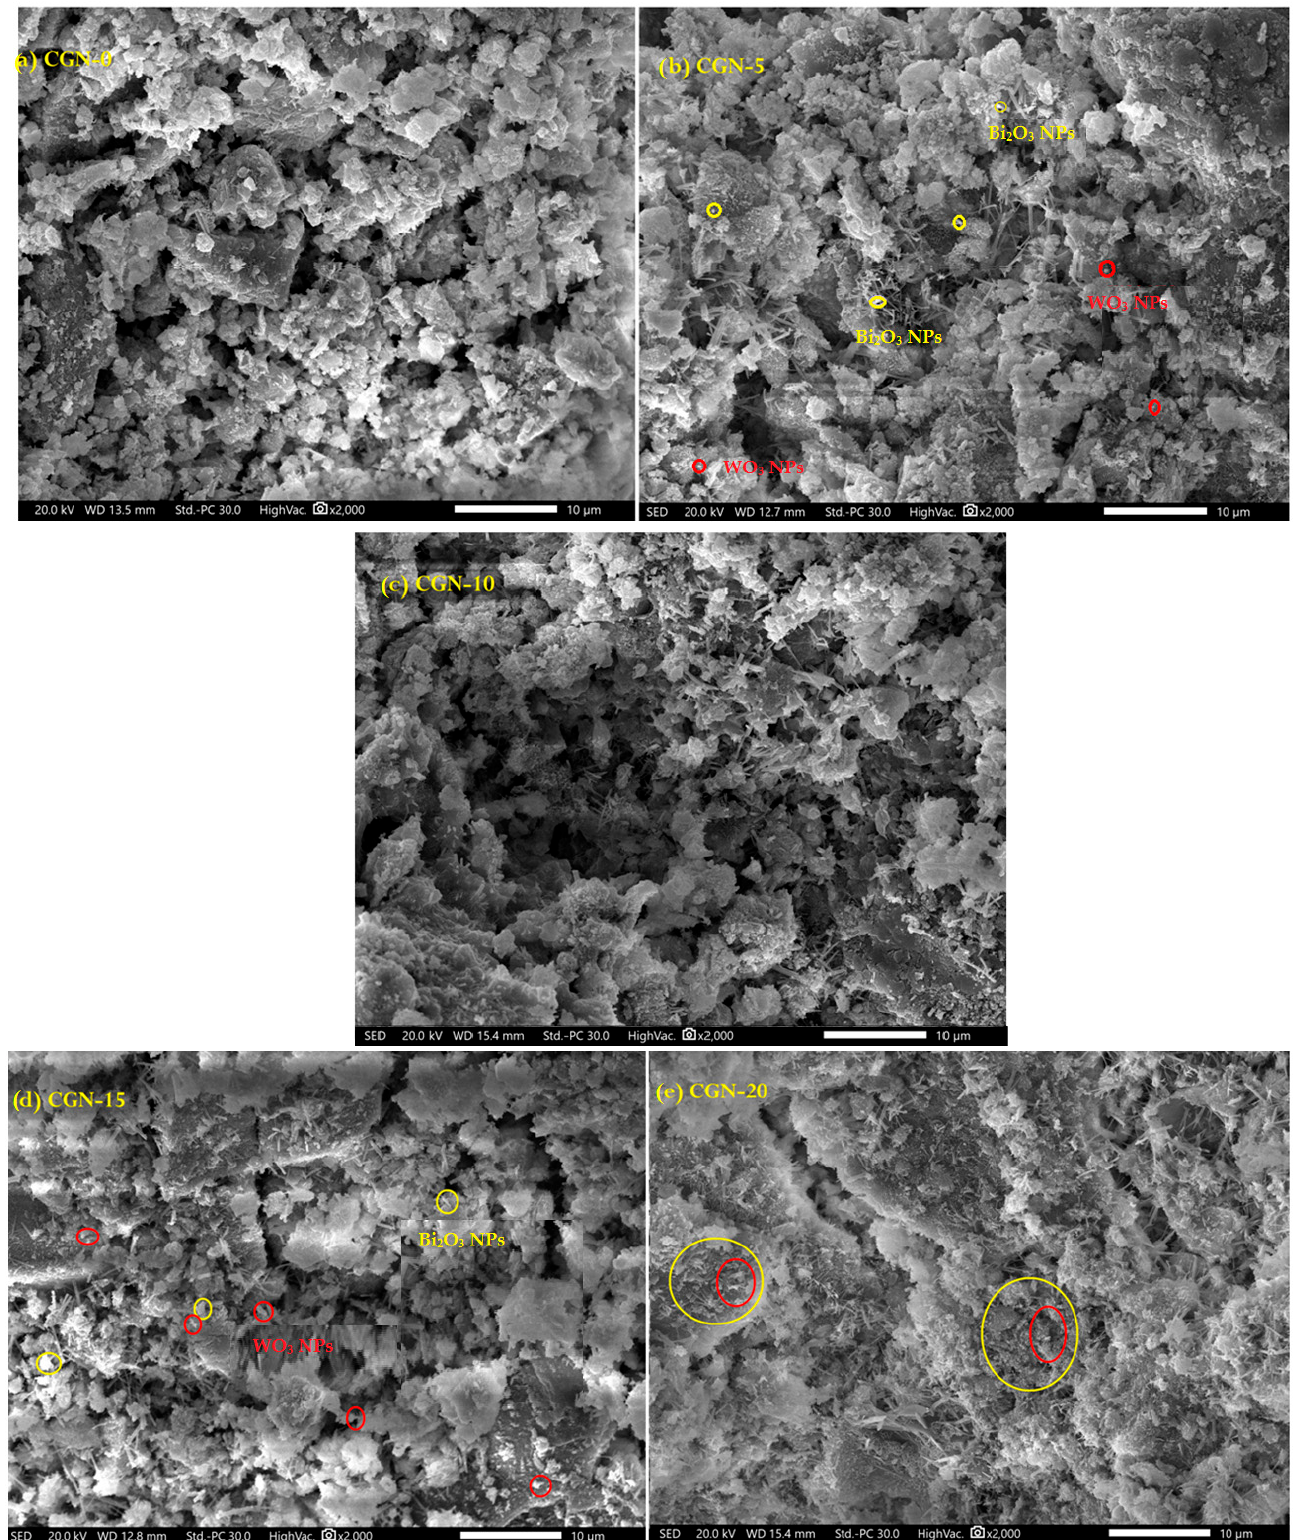
Figure 5. SEM images of prepared mortars, ( a ) CGN-0, ( b ) CGN-5, ( c ) CGN-10, ( d ) CGN-15, and ( e ) CGN-20.